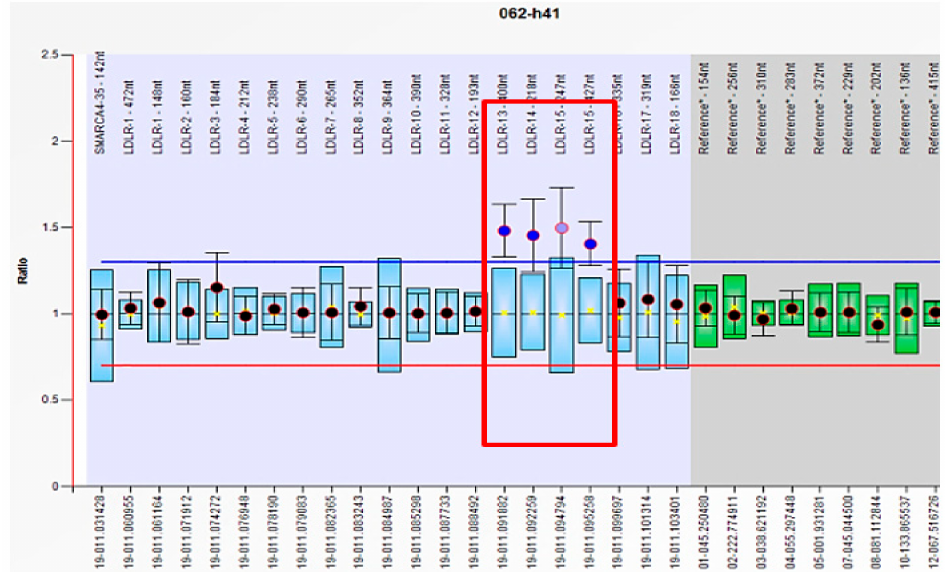
Figure 4. Multiplex ligation-dependent probe amplification (MLPA) method shows the duplication (ratio~1.5) in LDLR exons 13–15 in patient H41-exon numbers were shown above as “LDLR-number of exons” (the LDLR exon numbering uses the RefSeq transcript NM_000527.4). The reference probes were included for normalized probe-signal ratio. The arbitrary border (upper and lower) was placed ± 0.3 from the reference sample median of probes. According to the DLCN score, the FH patients without mutation had increased fre- quencies of probable FH and of defined FH, compared to FH patients with benign/likely benign/conflicting classification or pathogen/likely pathogen mutations ( χ 2 (2) = 5.7, p = 0.05) (Figure 5). Depending on the DLCN score, the subjects with probable FH had 4.9% pathogenic/likely pathogenic mutations and 16.4% benign/ likely benign mutations, while the individuals with definite FH had 4.9% pathogenic/likely pathogenic mutations and 1.6% benign/likely benign mutations (Figure